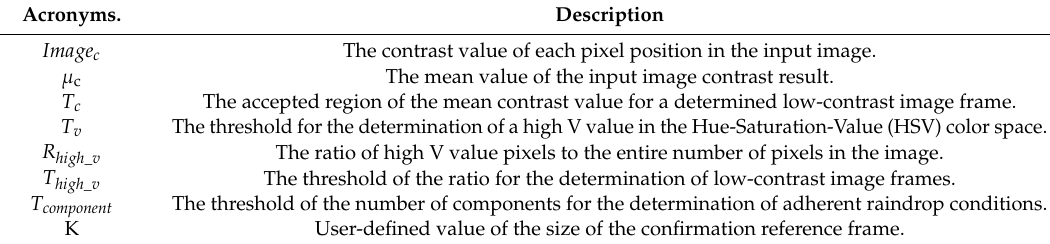
Figure 2. System flowchart. Table 1. Table of used